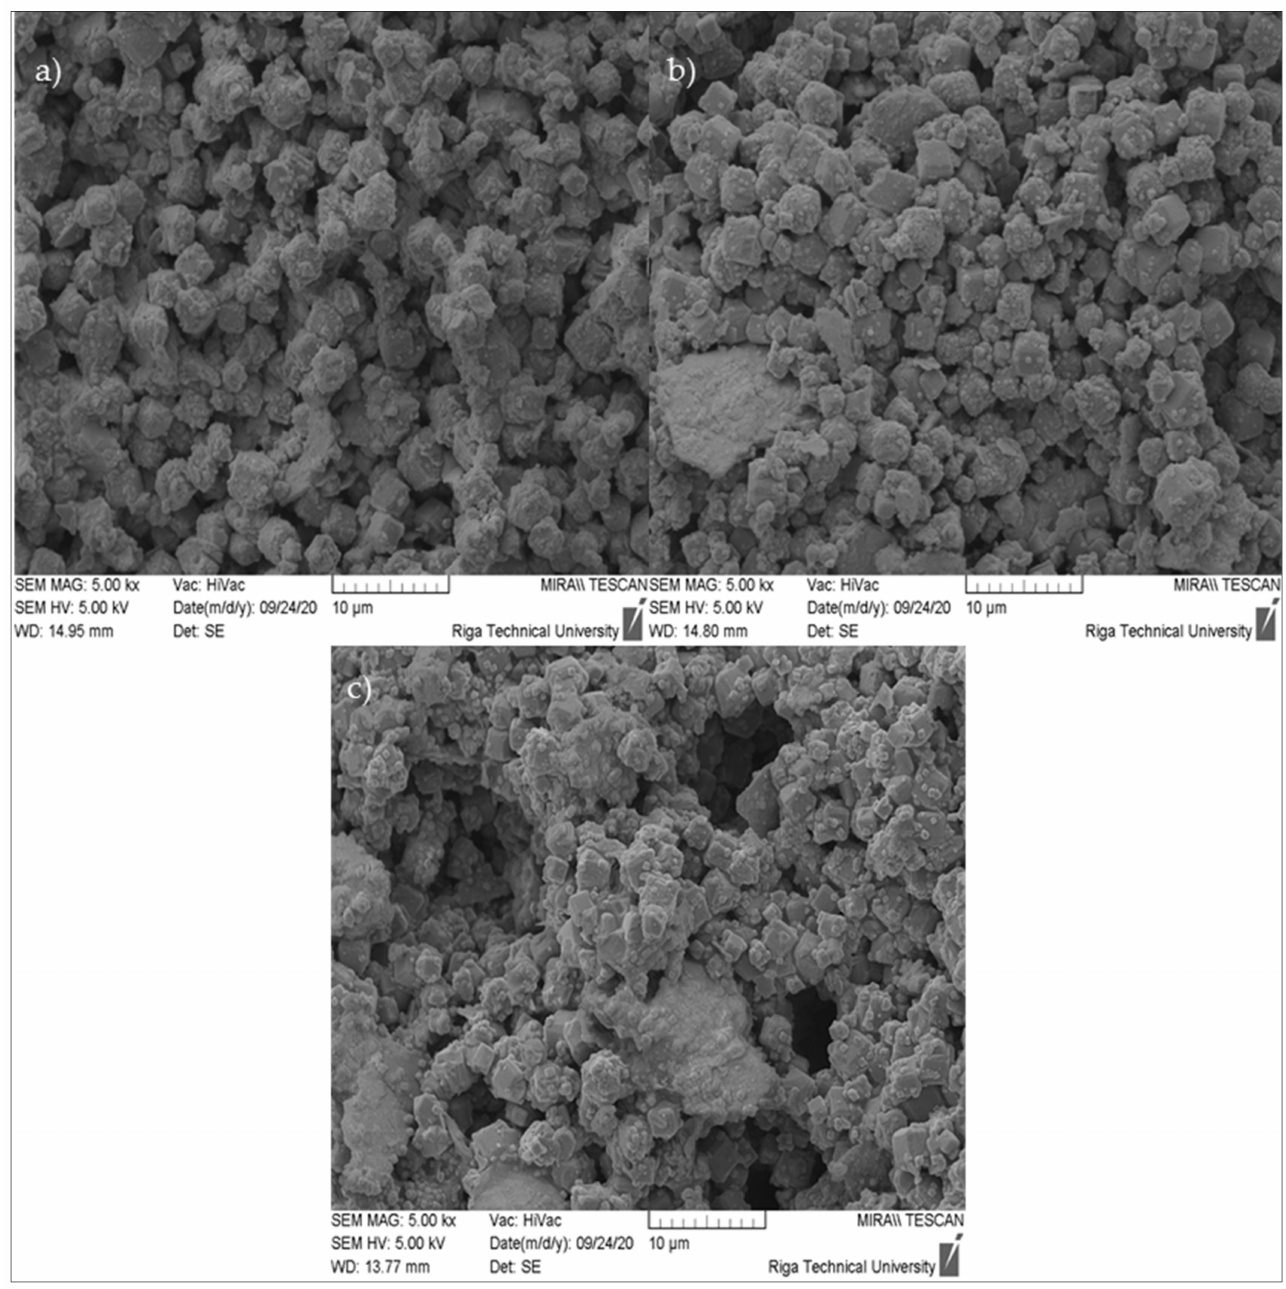
Figure 13. SEM micrographs of ZG samples (cross-section) at 5000 × magnification: ( a ) ZG-0.8; ( b ) ZG-1.0; ( c )